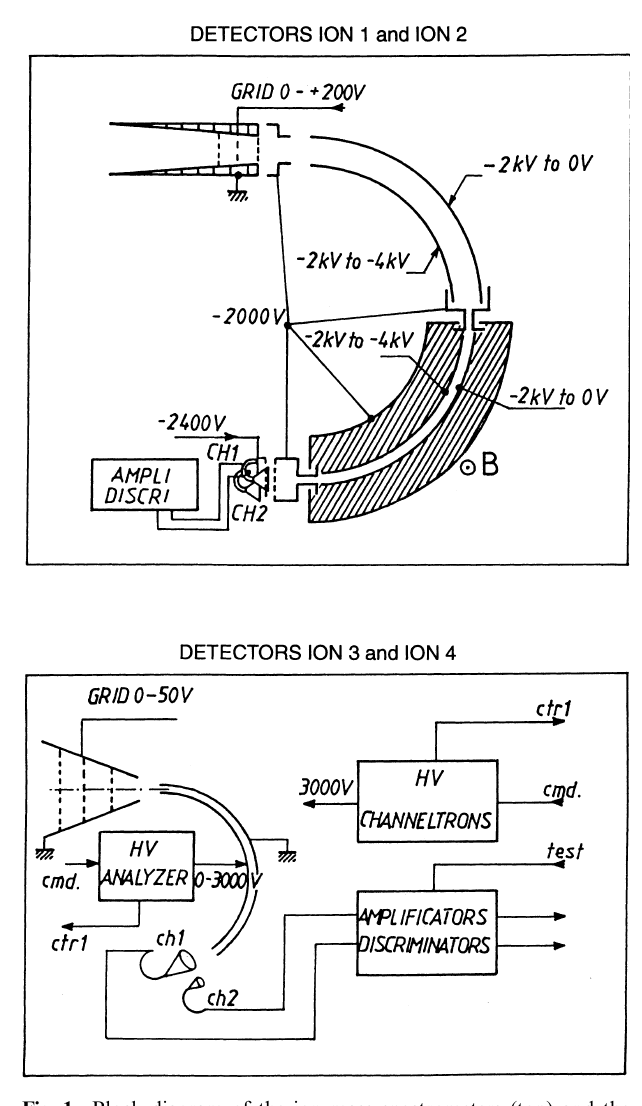
Fig. 1. Block diagram of the ion mass spectrometers (top) and the electron sensors (bottom)